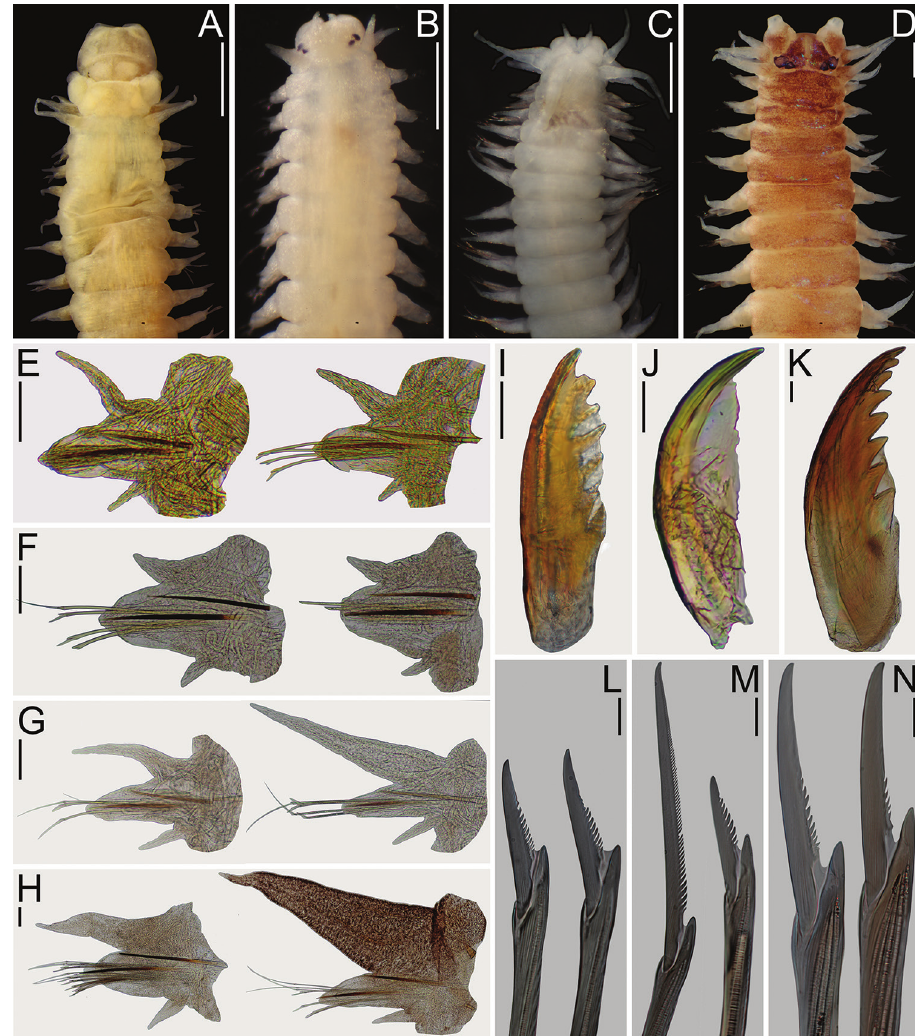
Figure 5. Morphological comparison among namanereidins. Namanereis hummelincki ( A, E ) (USNM 29715, 29716); N. cf. amboinensis ( B, F, I, L ) (ECOSUR P-2902); Namalycastis occulta ( C, G, J, M ) (ECOSUR P-2649); N. borealis D, H, K, N. A–D (ECOSUR P-2651). Anterior ends, dorsal view E–H Right parapodia from anterior (10, left) and posterior (right) chaetigers I–K Left jaws, dorsal view L–M Dorsalmost (left) and ventralmost (right) sub-acicular, heterogomph falcigers from chaetiger 10. Scale bars: 0.5 mm ( A–D ); 0.1 mm ( E–H ); 50 µm ( I–K ); 10 µm ( L–N ).